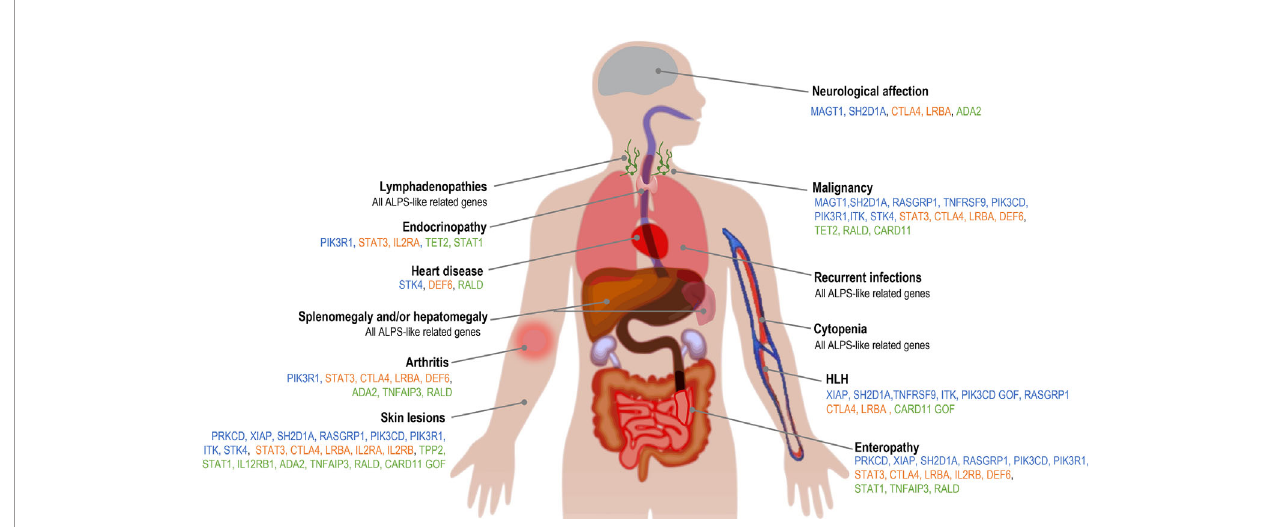
FIGURE 2 | Clinical features associated with ALPS-like disorders. Blue: ALPS-like related genes with EBV-susceptibility; orange: ALPS-like related genes with regulatory T-cells defect; green: other ALPS-like related genes.